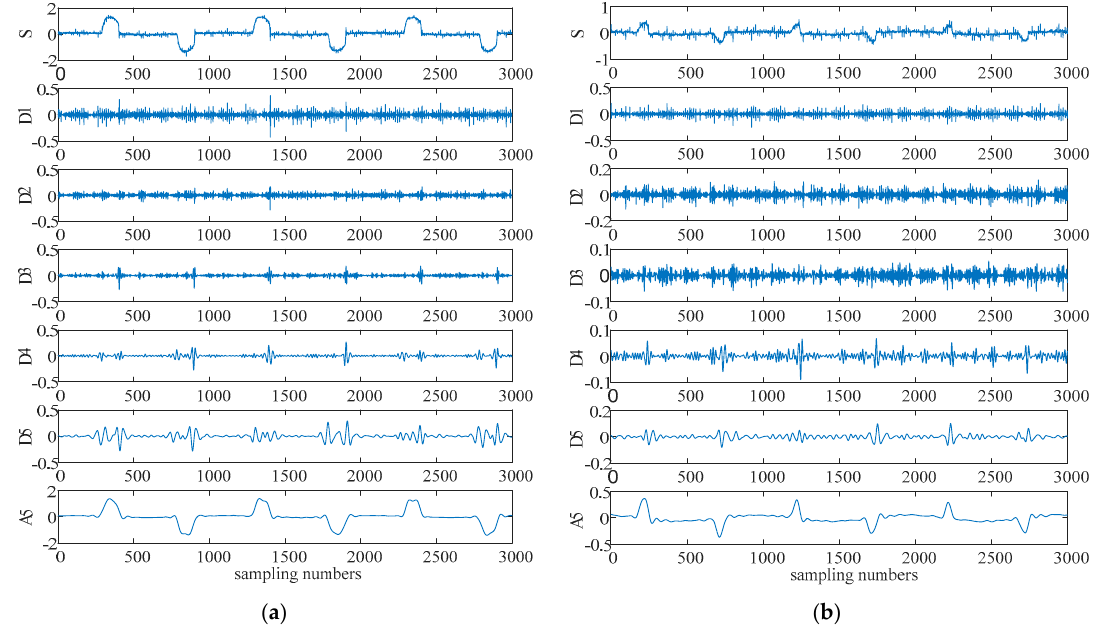
Figure 2. Wavelet decomposition reconstruction signal diagram: ( a ) normal current; ( b ) arcing current.